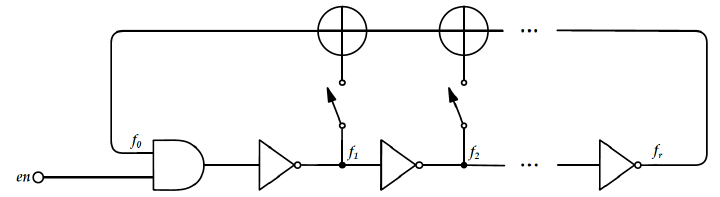
Figure 5. Fibonacci Ring Oscillator with enable port.